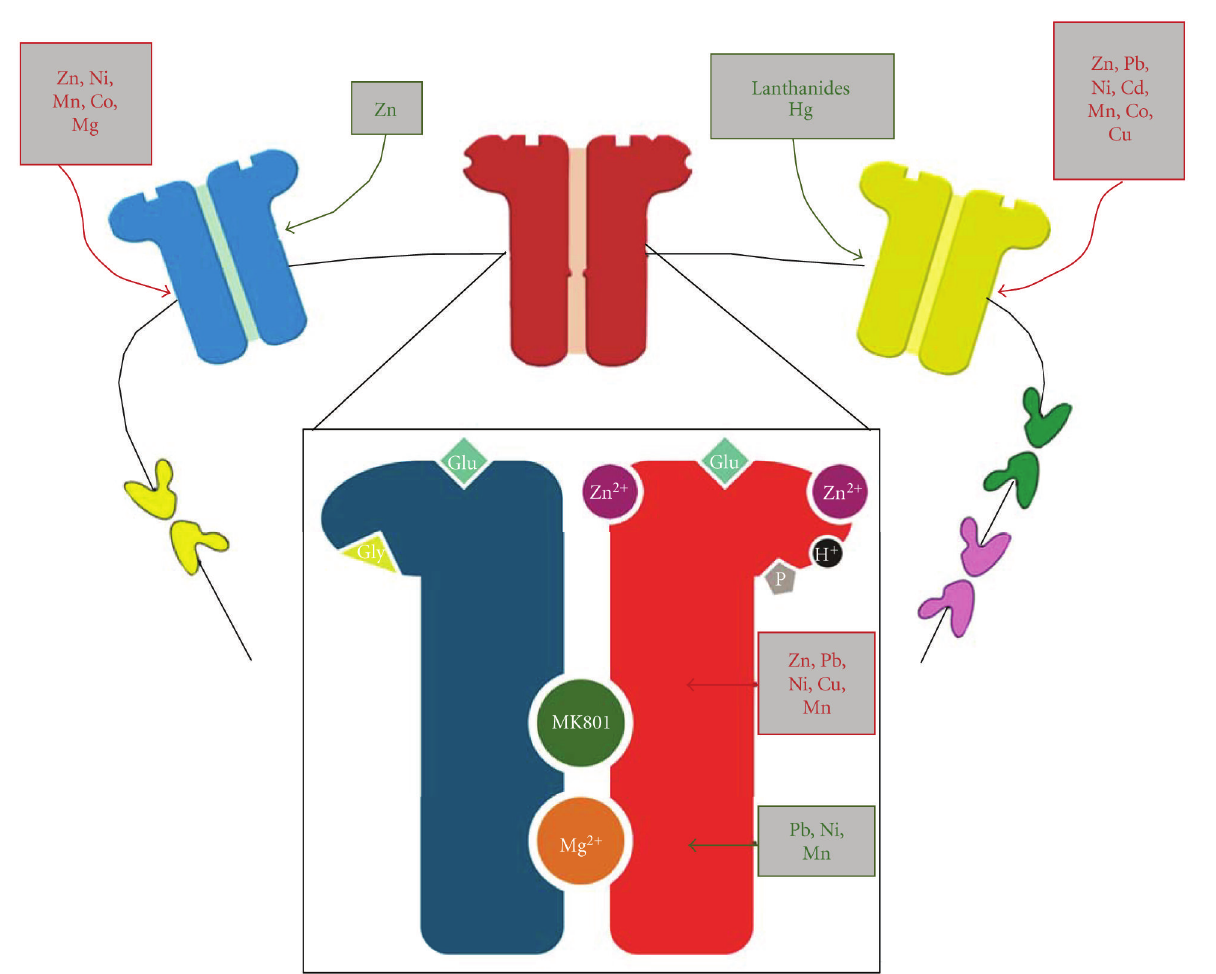
Figure 4: Postsynaptic ligand-gated ion channels as targets of neurotoxic metals. The main postsynaptic channels are the AMPA/kainate and NMDA receptors whereas the main inhibitory receptors are the GABA A Rs. Each receptor represents a target for multiple metals. The NMDAR has many modulatory sites identified as it is more extensively studied. NMDAR is composed of a heteromer made of NR1 and NR2, each having multiple subtypes. In the diagram blue arm represents NR1 while the red arm represents NR2, the main modulatory subunit. Most metals have been shown to have e ff ects on NR2 subunit (for values regarding the specific subtypes refer to Section 3.1 and Table